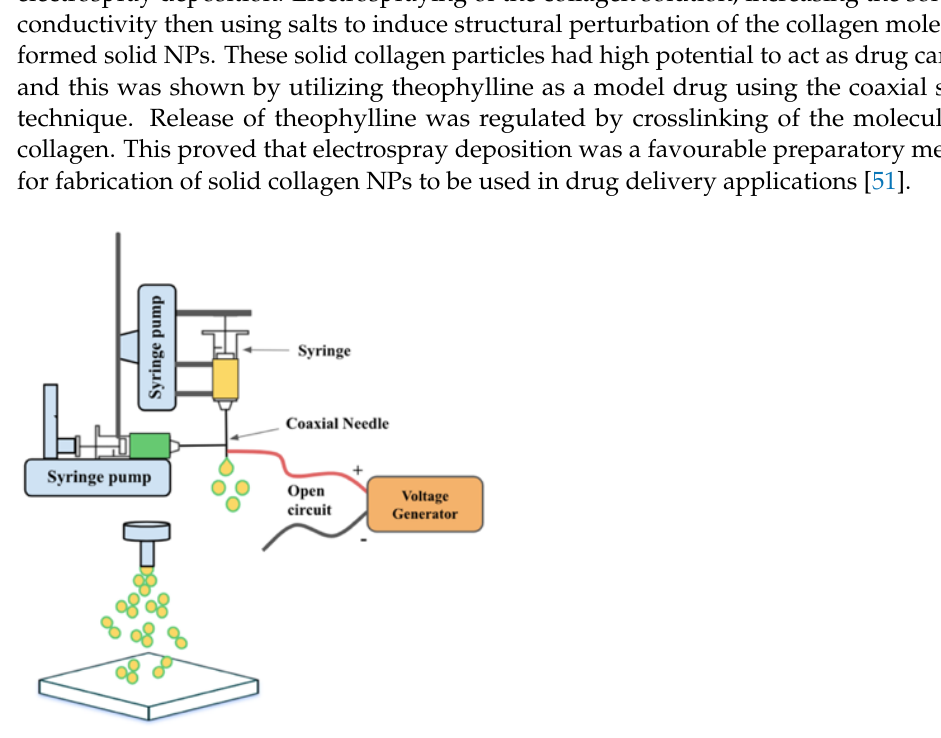
Figure 5. Electrospraying—NPs are fabricated by releasing a liquid jet stream through a nozzle (coaxial needle), forming an aerosolized droplet after exerting high voltage to the protein solution. High voltage is applied to the polymer solution to make sure it comes out of the syringe as NPs.